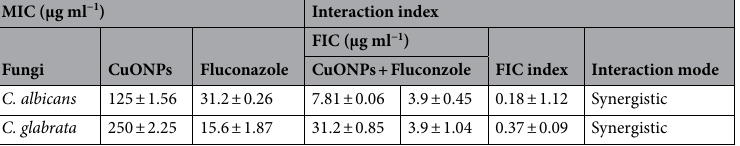
Table 3. Minimum inhibitory concentration (MIC) against pathogenic fungi alone and in combination with antifungal (fluconazole) along with interaction index. Experiments were performed in triplicates; mean ± SD are shown. Average of three independent determinations.